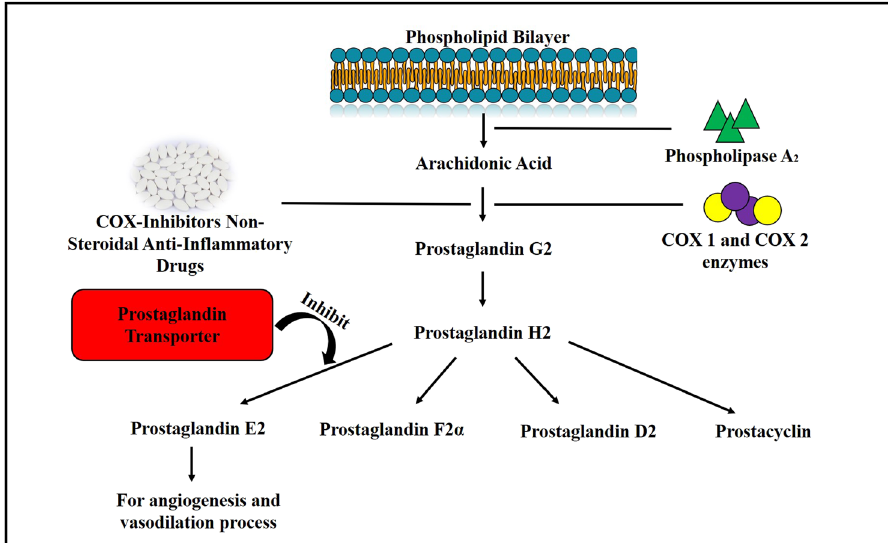
Figure 1: Mechanism of prostaglandin